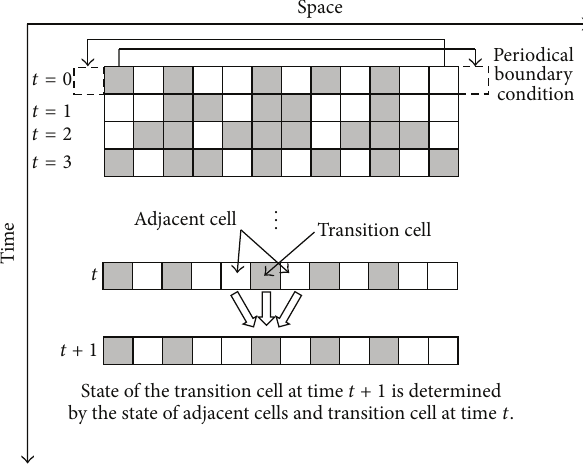
Figure 2: Outline of the one-dimensional cellular automata model. The horizontal direction denotes space and the vertical direction denotes time. Periodic boundary conditions are assumed and each square cell has one state, 0 or 1, as attribute. The next cell state is determined by three cell states, that of the cell and the two adjacent cells.